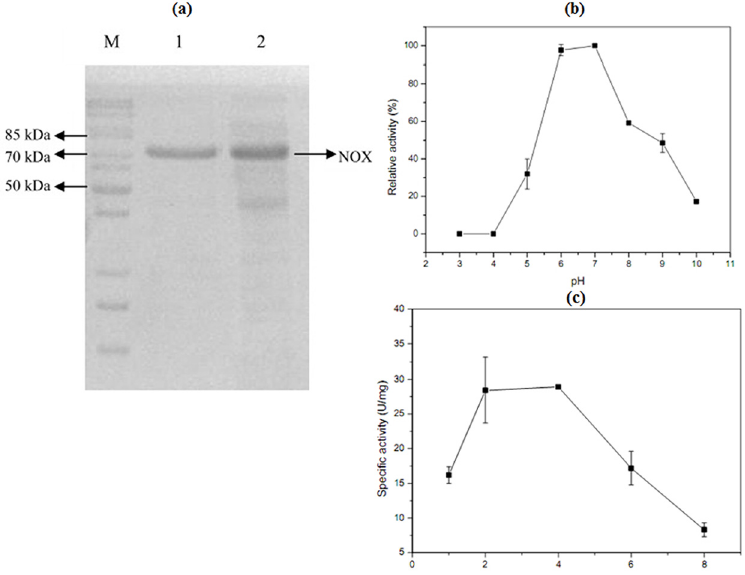
Fig 2. Characterization of the NOX and SDS-PAGE analysis of the purified NOX. (a) 10% SDS-PAGE analysis of the purification NOX. Lane M: protein marker; Lane 1: purified NOX with His-tag; Lane 2: recombinant bacterium (harboring pET-32a- nox ) induced by IPTG. (b) Optimal pH for NOX. (c) The optimal inducing time of NOX.